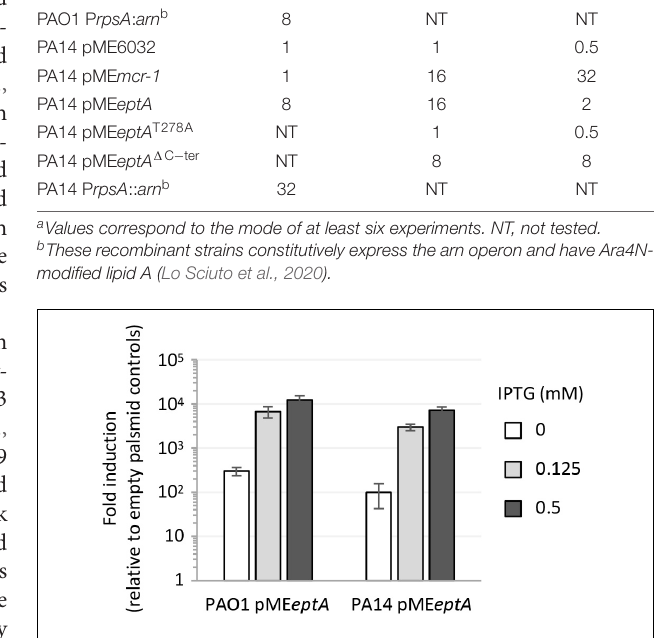
FIGURE 2 | Expression level of eptA , determined by qRT-PCR, in P. aeruginosa PAO1 or PA14 carrying pME eptA cultured in the presence of increasing IPTG concentrations. Relative eptA gene expression is shown as fold induction with respect to the cognate strain carrying the empty plasmid pME6032. Data represent the mean ( ± SD) of two independent experiments performed in